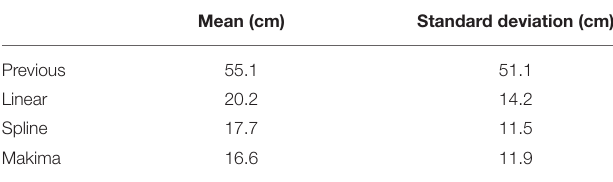
TABLE 2 | Overall performance of different interpolation methods in